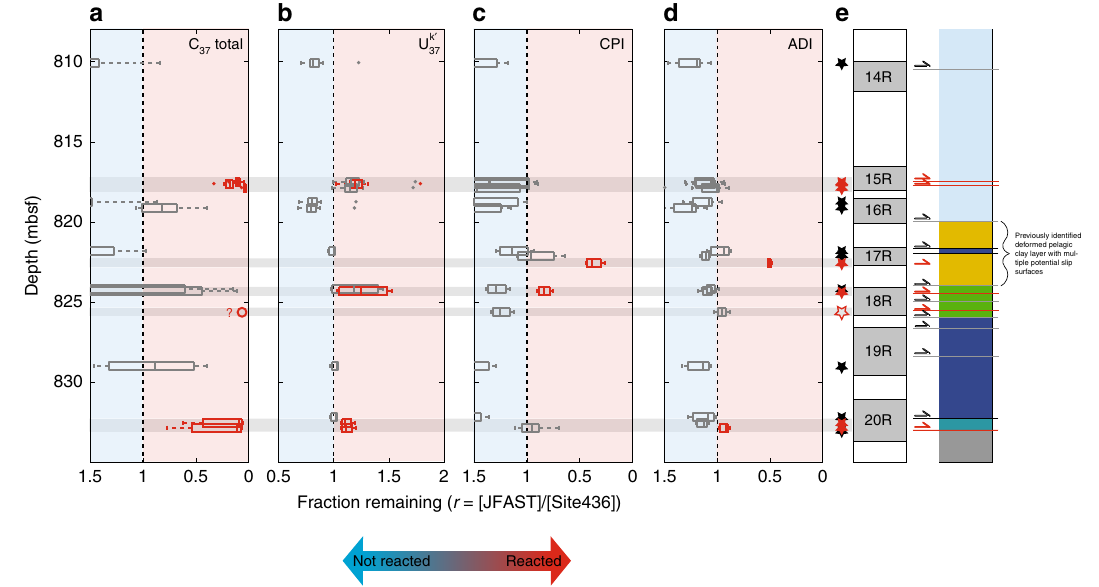
, ( c ) CPI, and ( d ) ADI are shown for 37